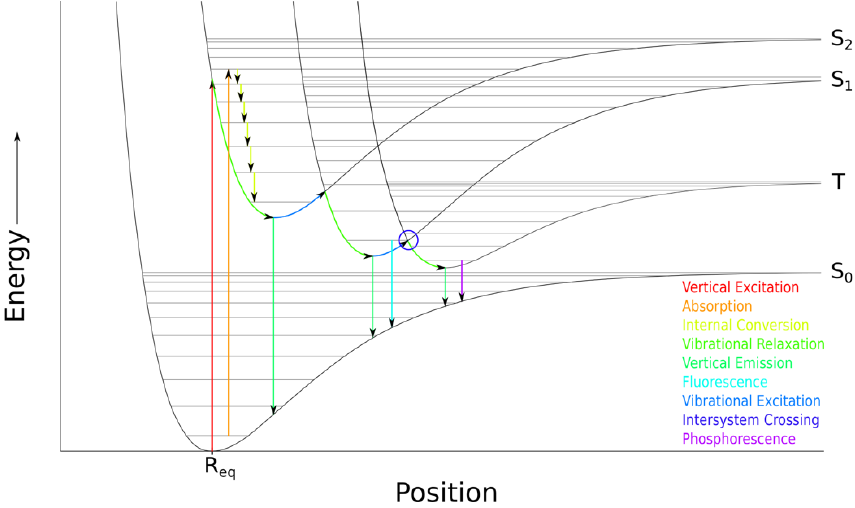
Figure 1. Simplified Franck – Condon energy well diagram. Herein we report the synthesis and investigation of meso -(2-pyridyl) and meso -(3- pyridyl)-BODIPYs, and of their 2,6-dichloro and pyridinium derivatives (see Figure 3) and compare their photophysical, electrochemical and cytotoxic properties relative to the known meso -(4-pyridyl) and meso -(4-pyridinium) derivatives and their 2,6-dichloro analogs. The moderate electron-withdrawing chlorine atoms are easily introduced at the 2,6-positions and expected to induce red-shifts in the absorption and emission wavelengths, increase reduction potentials, increase stability, and enhance the relative fluorescence quantum yields in both organic solvents and water. This type of BODIPY and halogenated derivatives could find multiple applications as optical sensors, fluorescent probes, or as sensitizers for